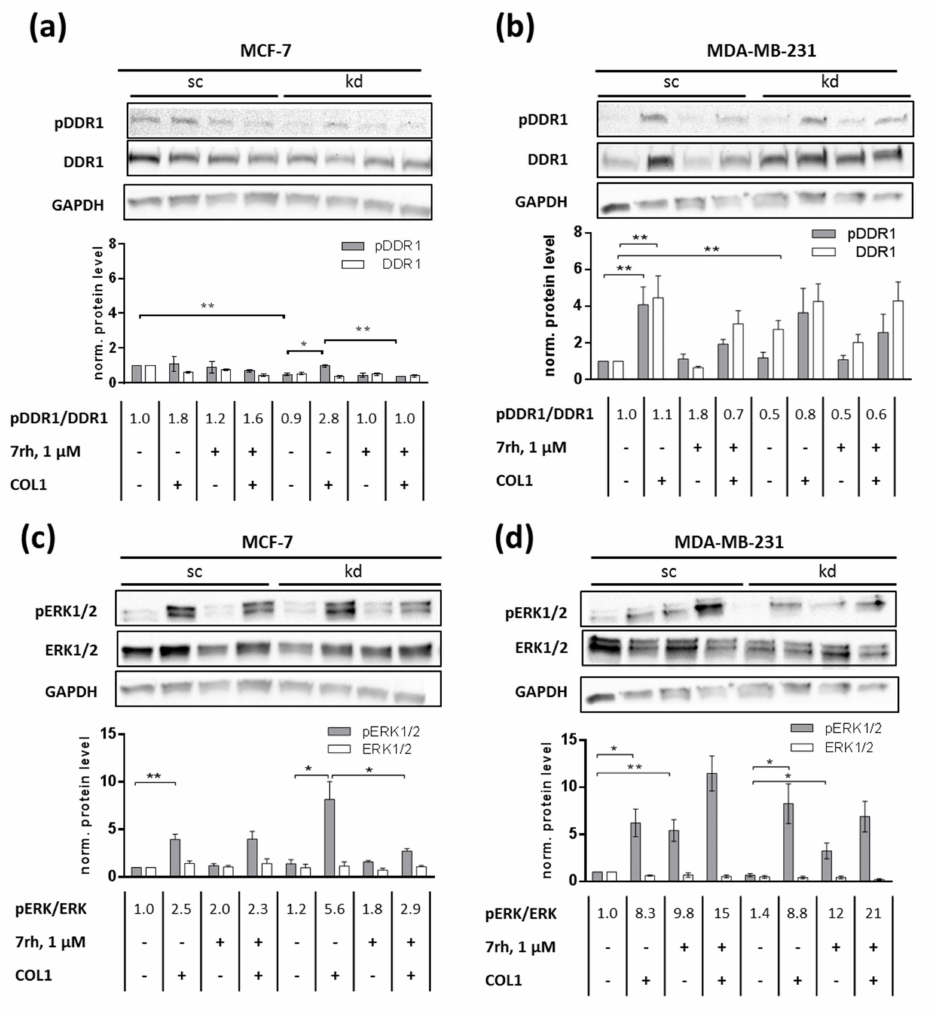
Figure 3. The role of Discoidin Domain Receptor 1 (DDR1) as a collagen type 1 (COL1) receptor in MCF-7 ( a ) and MDA-MB-231 ( b ) (scrambled, sc) cells upon integrin β 1 -knockdown (kd) for the induction of COL1-mediated signaling via ERK1 / 2 ( c , d ). DDR1 is significantly increased in MDA-MB-231kd cells. Western blot data also indicate that DDR1 is activated by COL1 in both cell lines and DDR1 inhibition by 7rh attenuates pDDR1 and pERK1 / 2 in MCF-7kd cells. In contrast, DDR1-inhibition by 7rh increased pERK1 / 2 in MDA-MB-231 cells. GAPDH was used as loading control. Data represent means ± SEM of at least n = 3 biological samples, statistical analysis was performed using unpaired t -test (* p < 0.05; ** p <